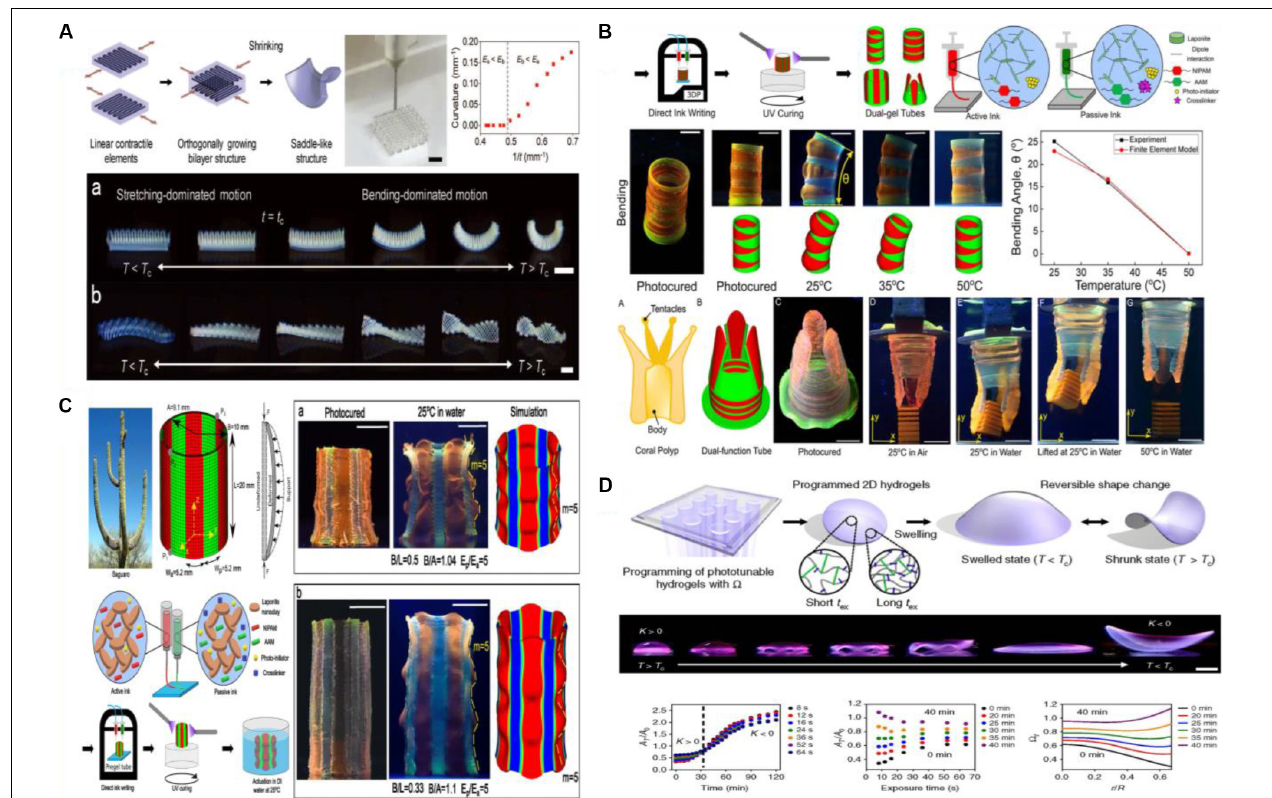
FIGURE 7 | Heat-induced shape-changing structures fabricated by 3D printing technology. (A) Bioinspired shape-changing structures fabricated by temperature-responsive linear hydrogel (Arslan et al., 2018). Reproduced with the permission of WILEY-VCH Verlag GmbH & Co. KGaA, Weinheim. (B,C) Bioinspired shape-changing tube structures fabricated by soft swellable poly N-isopropylacrylamide and stiff non-swellable polyacrylamide (Liu et al., 2019a,b). Reproduced with the permission of the American Chemical Society, 2019 Elsevier Ltd. (D) Bioinspired 3D shape-changing structures with programmable morphologies and motions (Nojoomi et al., 2018). Reproduced with the permission of Nature